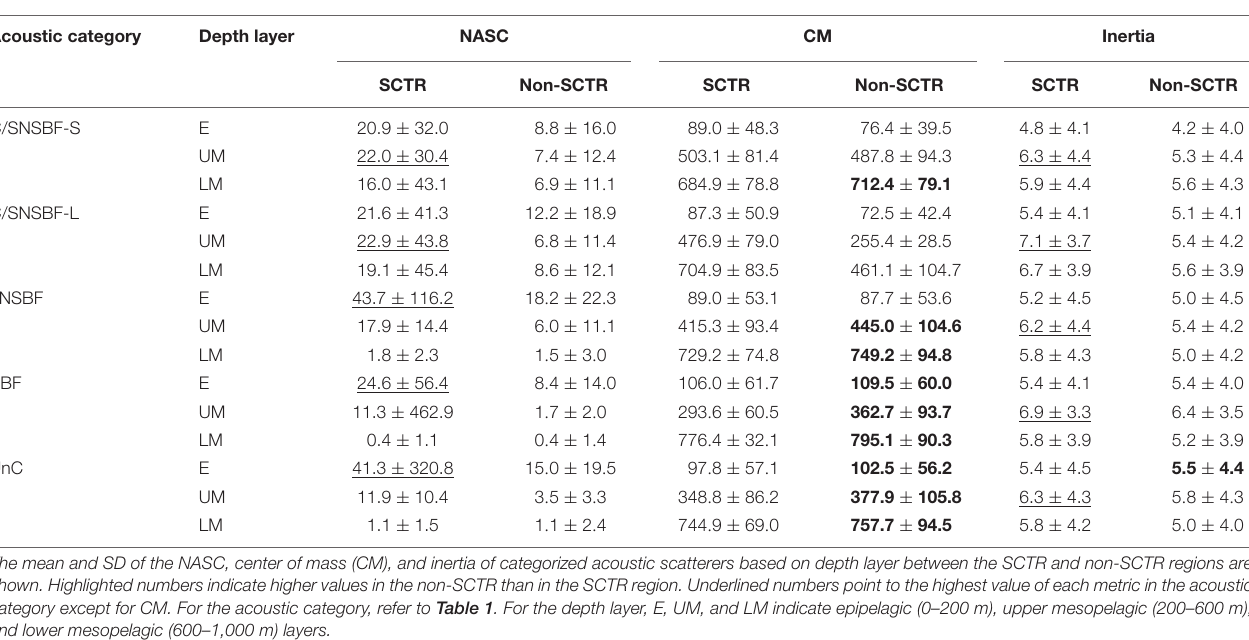
TABLE 2 | Metrics of categorized acoustic scatterers.